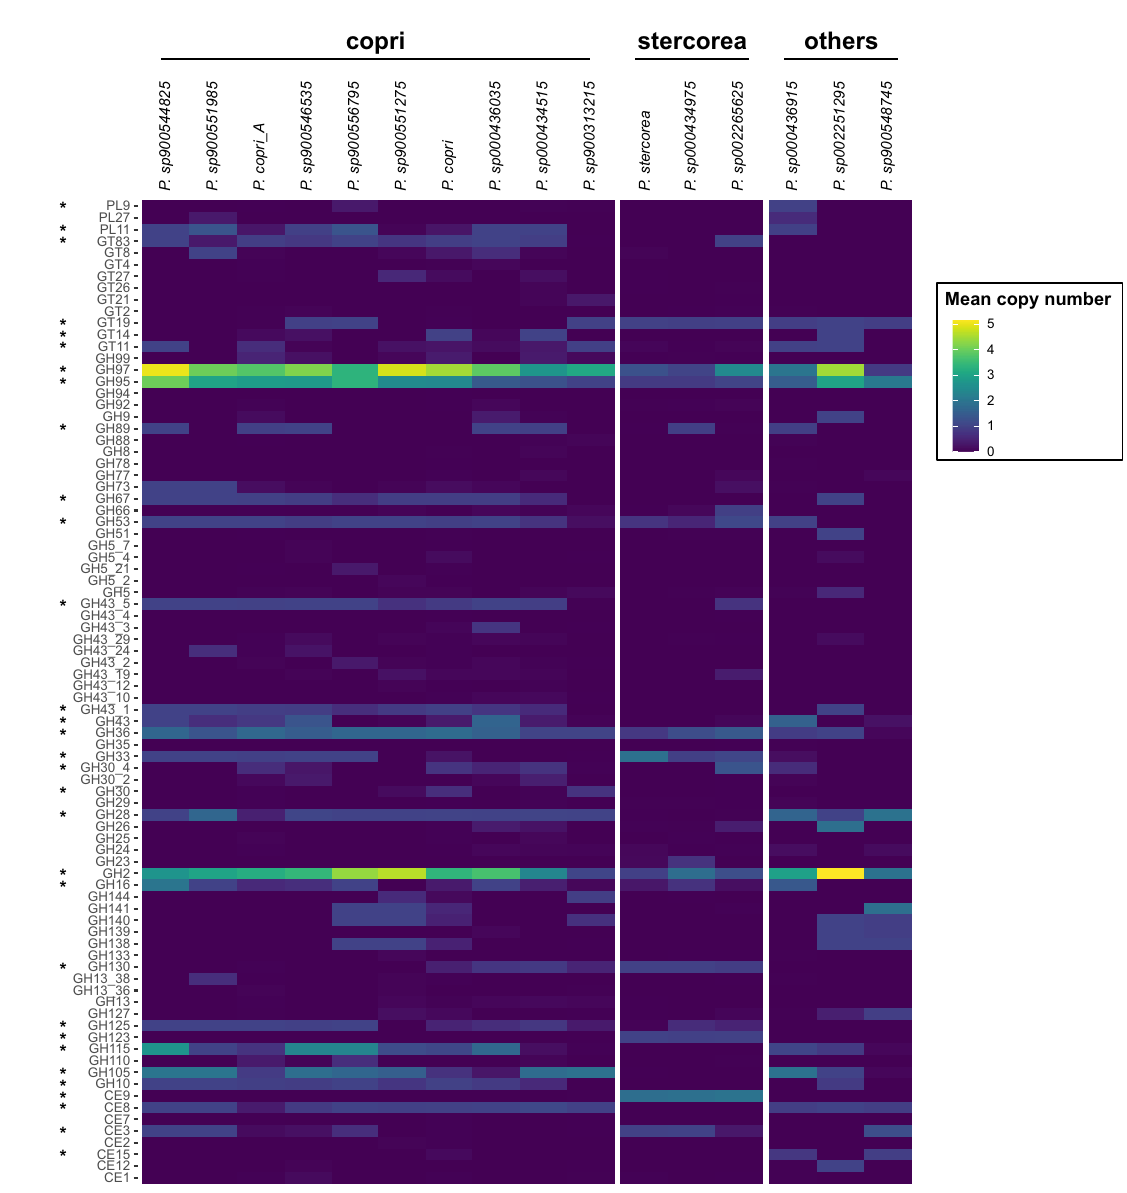
Figure 3. Distribution of carbohydrate active enzyme (CAZy) families in human gut Prevotella (average copies per genome). Only genomes with > 1% relative abundance or > 50% prevalence as indicated in Fig. 2 are included. CAZy families were identified in the genomes using Hidden Markov Models. Asterisks indicate families with statistically different copy counts (FDR < 0.001 Kruskal Wallis test with false discovery rate adjustment) and with at least one copy in any one of the three groups (copri, stercorea or other). See Table S7 for copy numbers. CE carbohydrate esterase, GH glycoside hydrolase, GT glycosyl transferase, PL polysaccharide